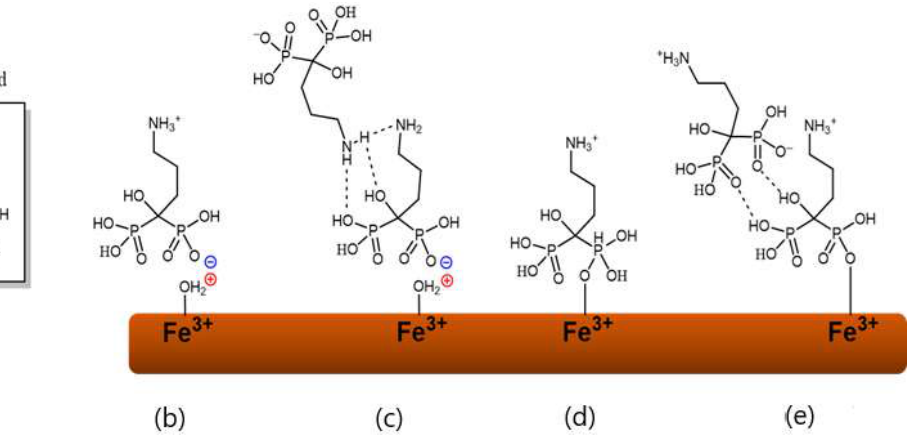
4 of 14 Table 1. Experimental conditions for coating the BSHF NPLs with APTES. Sample Name